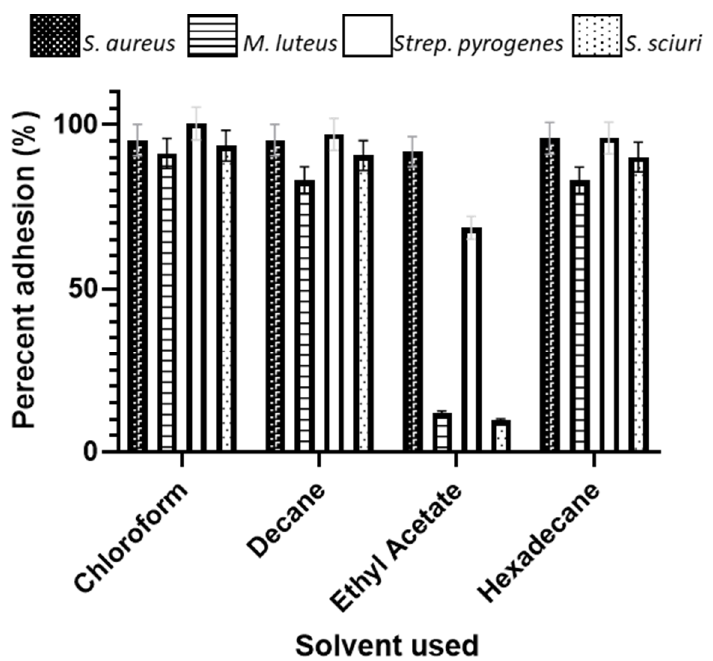
Figure 9. Microbial adhesion to hydrocarbon assay demonstrating the affinity for the bacterial species to solvents with different properties.